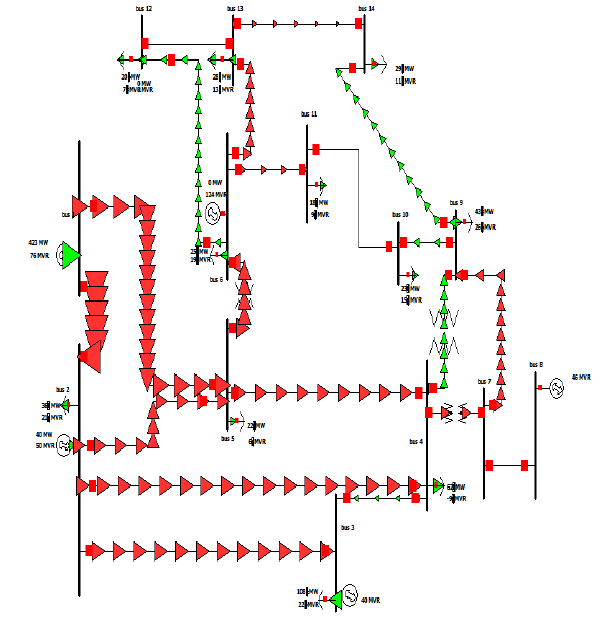
Fig1. IEEE 14 bus system with 60% uniform load increment on PWS Here, the red arrows show the overloading in the system and hence, to overcome from this we have to add new alternate lines in the network. The system data after simulating the system on PWS with a 60% load increment is given in